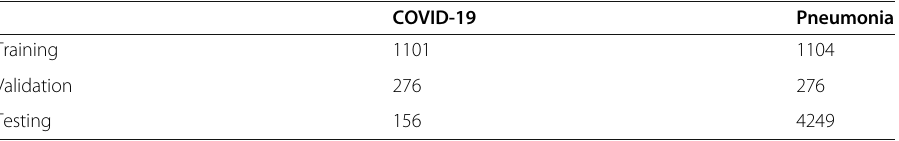
Table 2 Data for training, validation, and testing